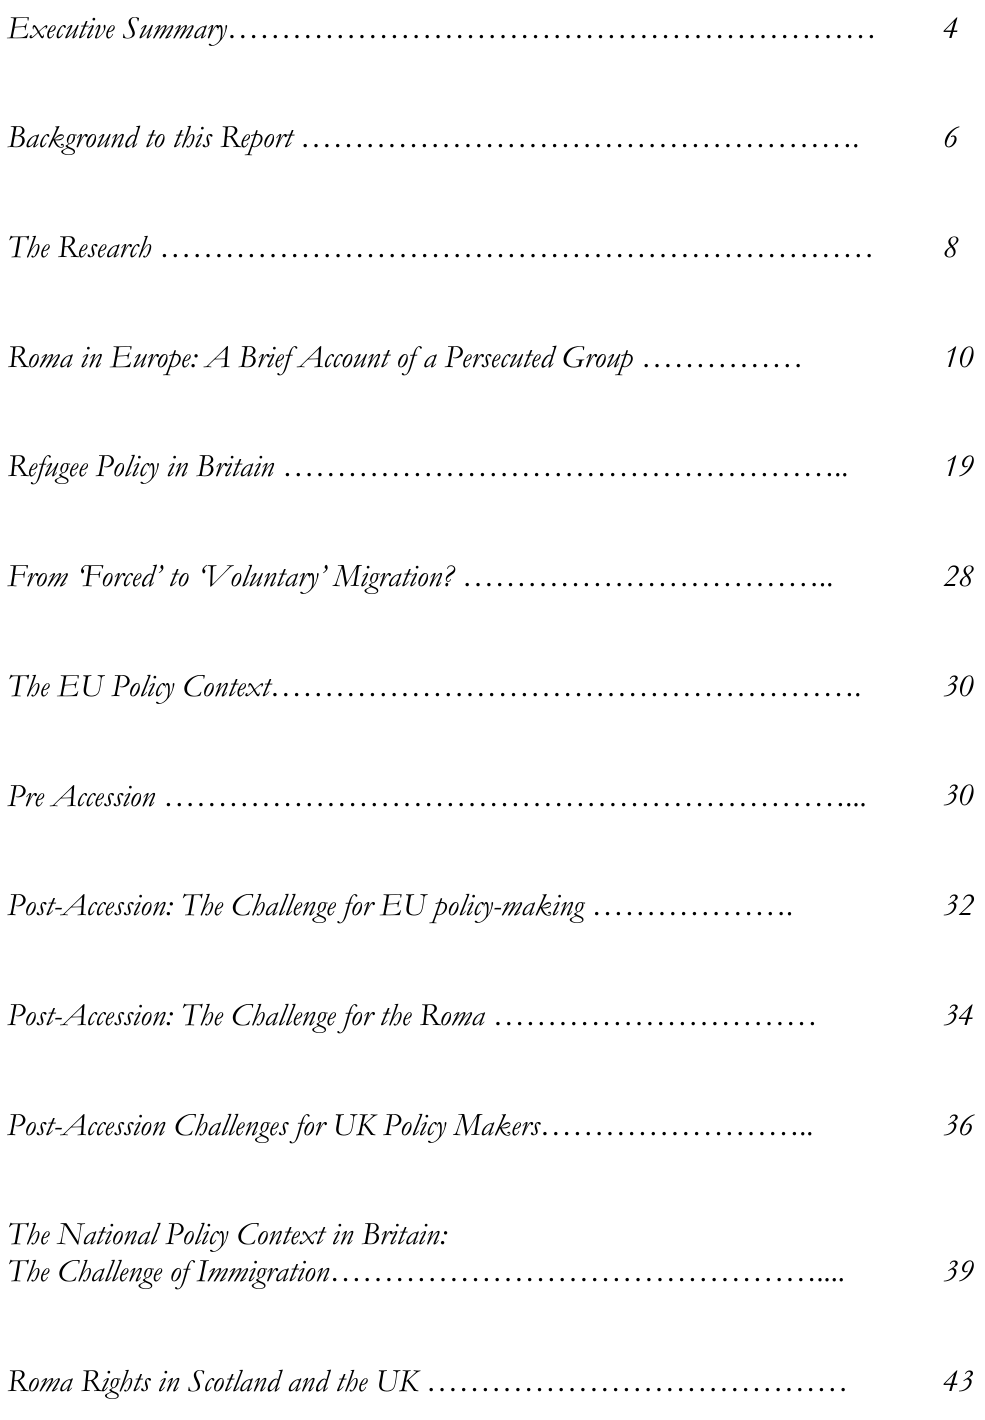
The National Policy Context in